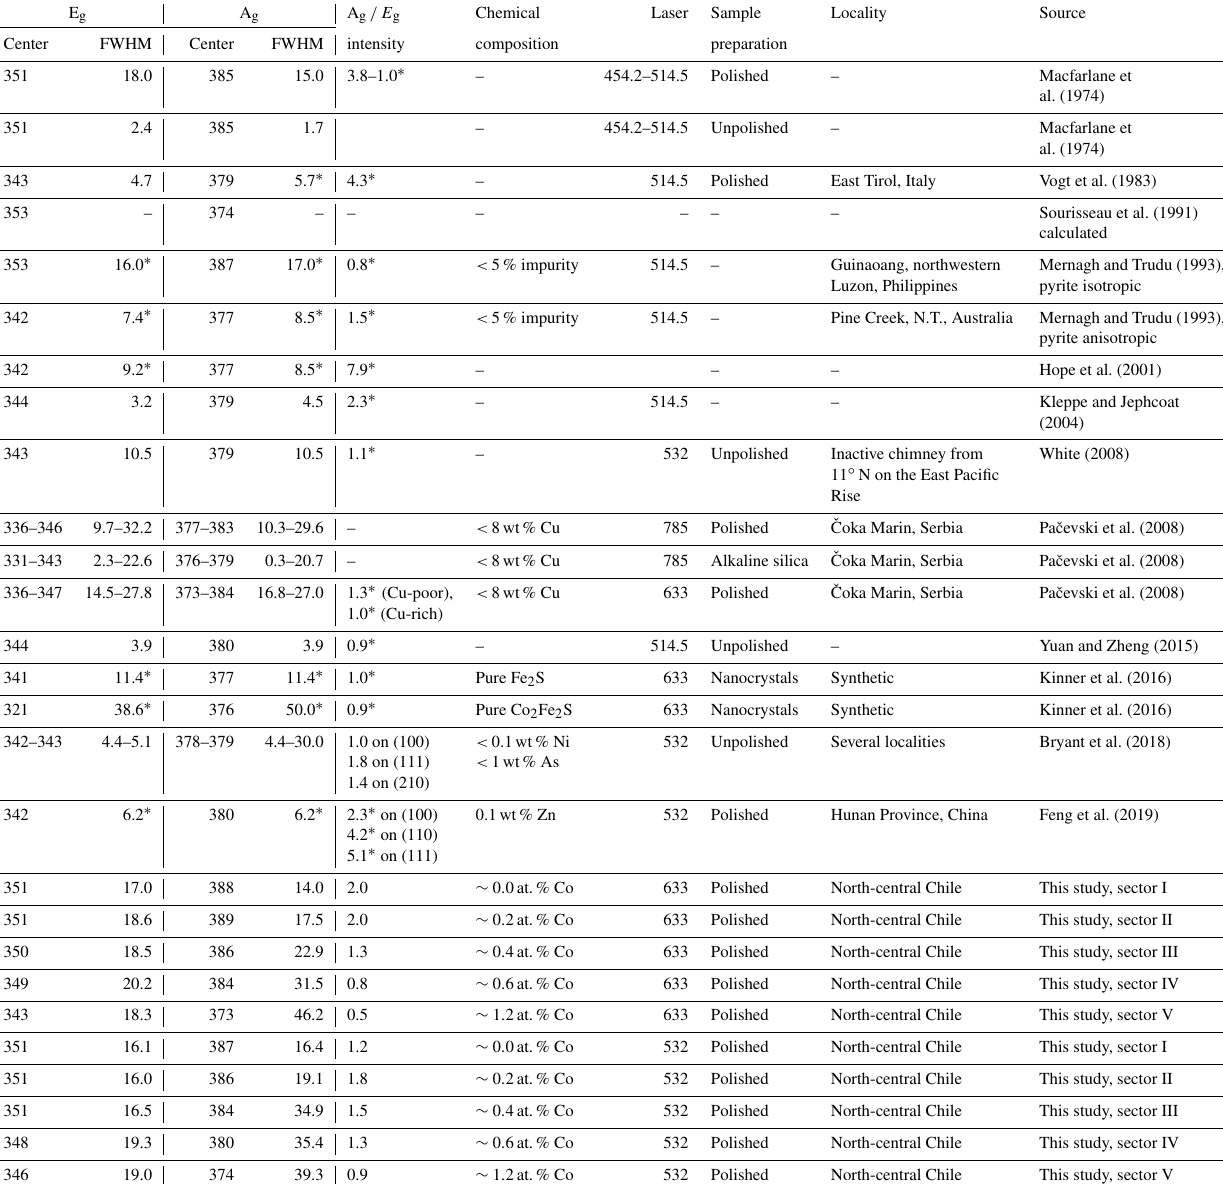
Table 2. Comparison of investigated and literature wavenumbers (cm − 1 ) for Raman spectrum of pyrite. T g (1) and T g (3) modes are not presented. E g